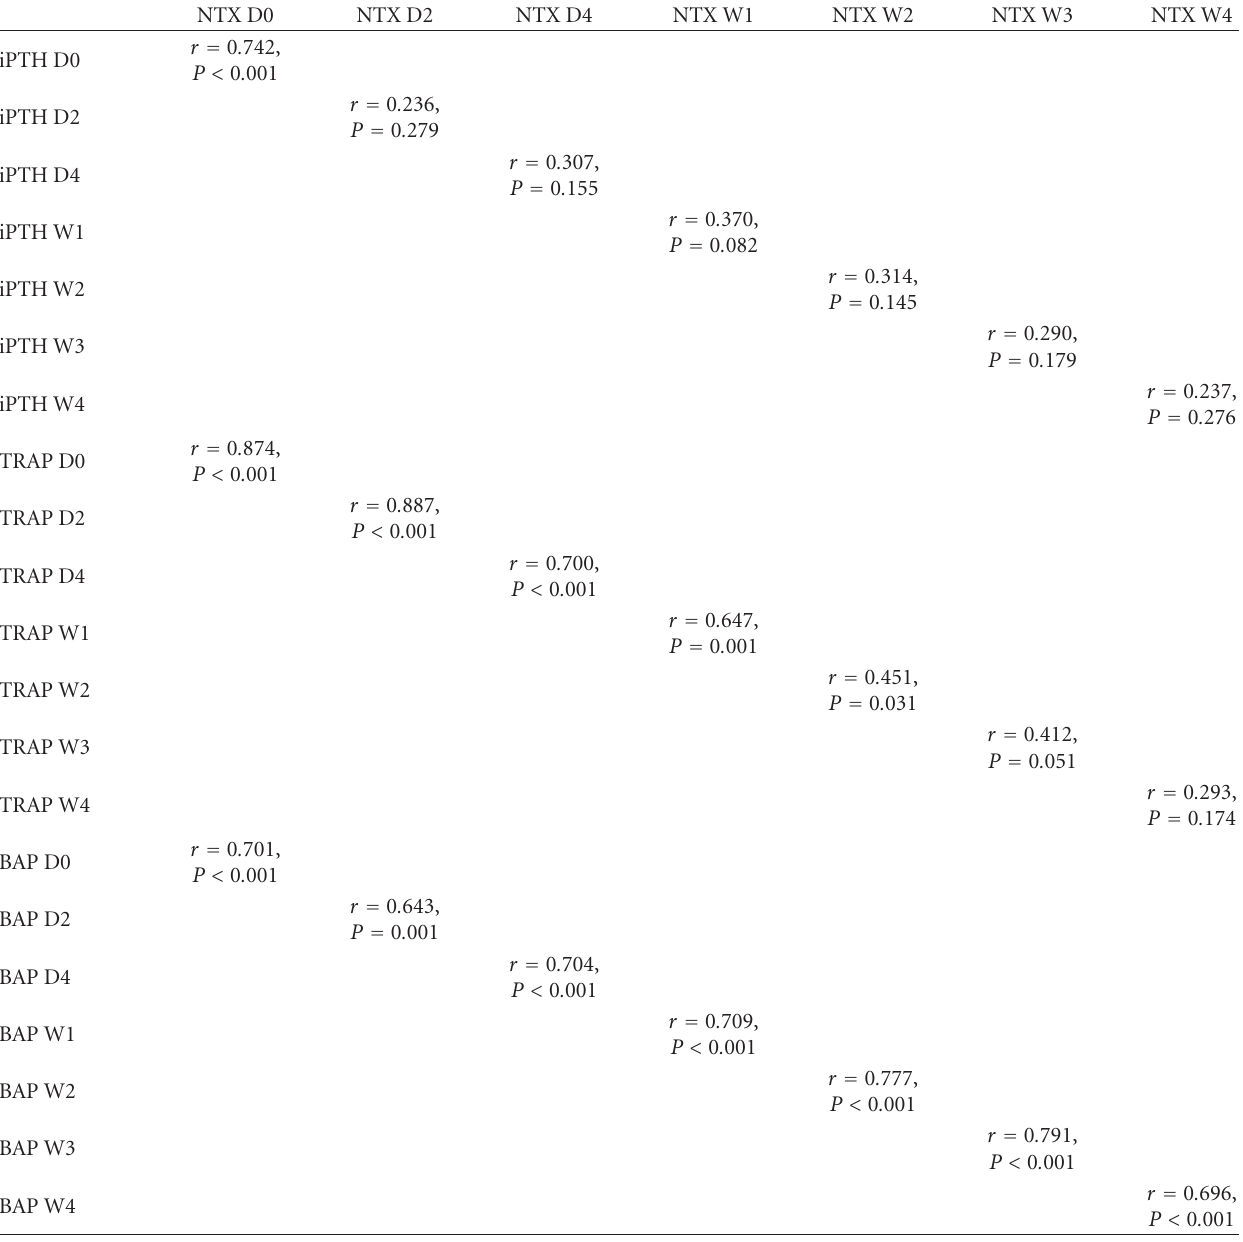
Table 3: The relationships between serum NTX and iPTH, TRAP, and BAP levels at di ff erent times after parathyroidectomy